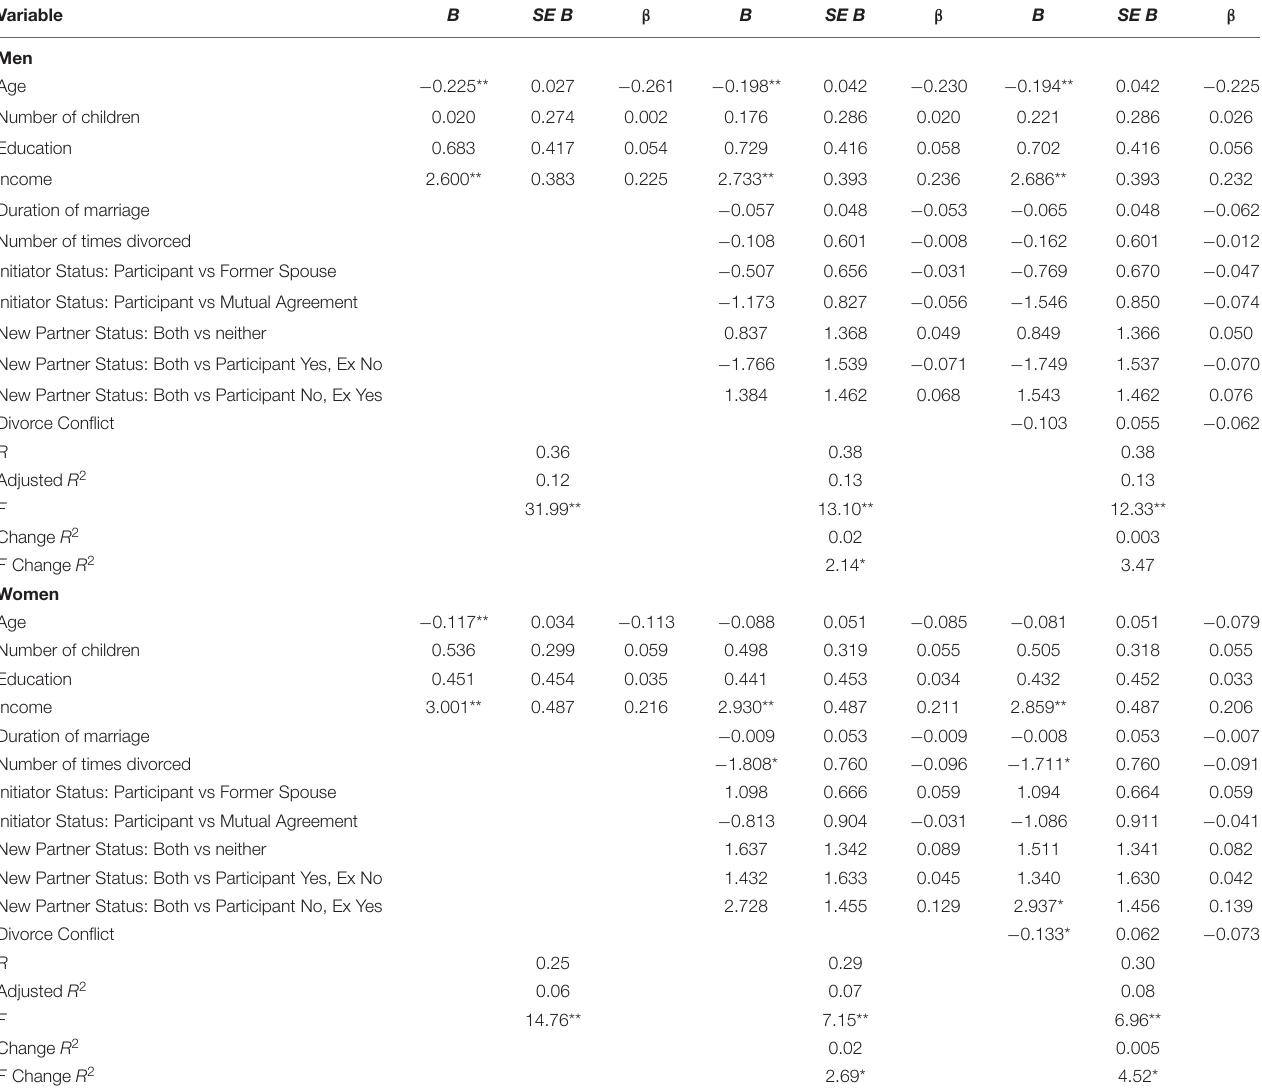
TABLE 3 | Multiple regression analyses predicting SF-36 physical health summary t